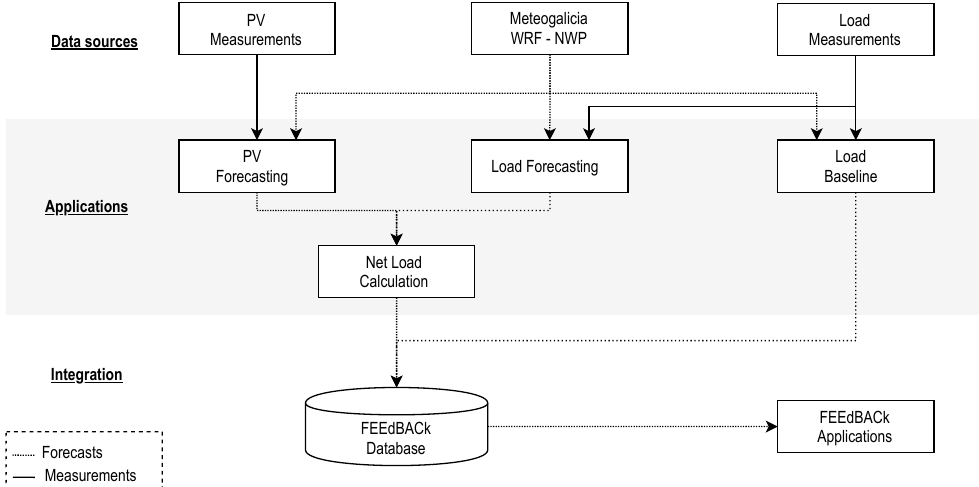
Figure 13. Block scheme of the net load and load baseline forecasting applications.